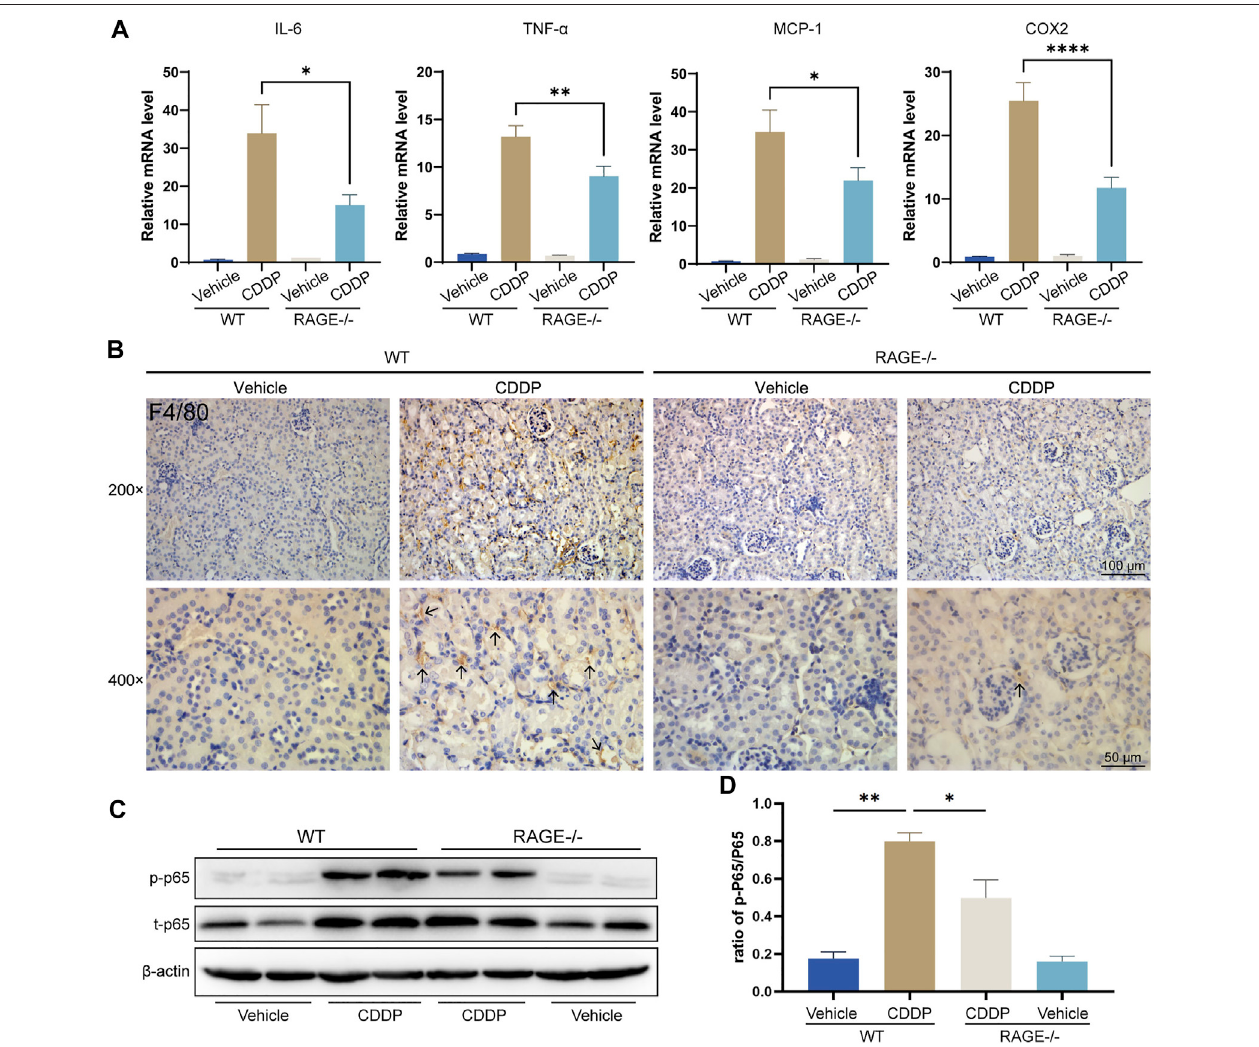
FIGURE3| RAGEknockoutmitigatedcisplatin-inducedrenalin fl ammation. (A) qPCRdetectionofmRNAlevelsofin fl ammation-relatedindicatorsinmousekidney, includingpro-in fl ammatoryfactorsIL-6andTNF- α ,chemokineMCP-1,andCOX-2. (B) Immunohistochemicalstainingofmousekidneyparaf fi nsections.Brownmarked by arrows means F4/80-positive, which indicates in fi ltration of macrophages. (C) The protein levels of phosphorylated p65 and total p65 were detected by western blot and then semi-quanti fi ed inahistogram (D) .One-wayANOVAwasused to compare means between groups. Dataareexpressed asmean ± SEM. Scalebar: 100 or 50 μ m as indicated in the fi gure. * p < 0.05, ** p < 01, **** p < 0.0001. p, phosphorylated; t,